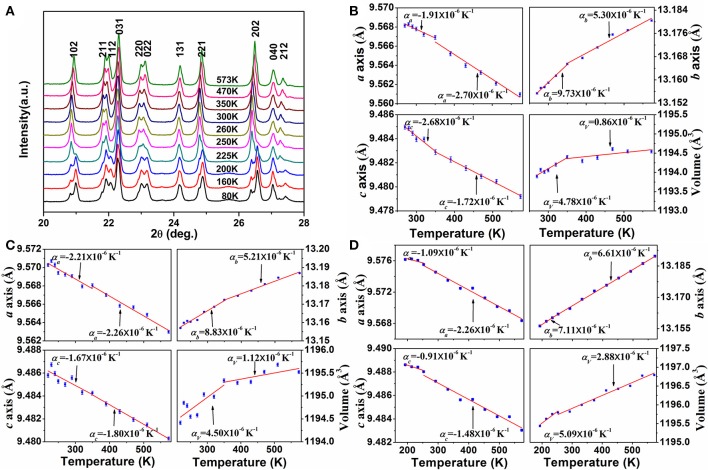
(A) Variable-temperature XRD patterns of HfMg0.7Zn0.3Mo3O12 (The XRD patterns were measured for 2θ = 10°-120°, here only a small range is shown for clarity); Changes of lattice constants and volume of HfMg1−xZnxMo3O12 with temperature: (B) for x = 0.3, (C) for x = 0.2, (D) for HfMgMo3O12.